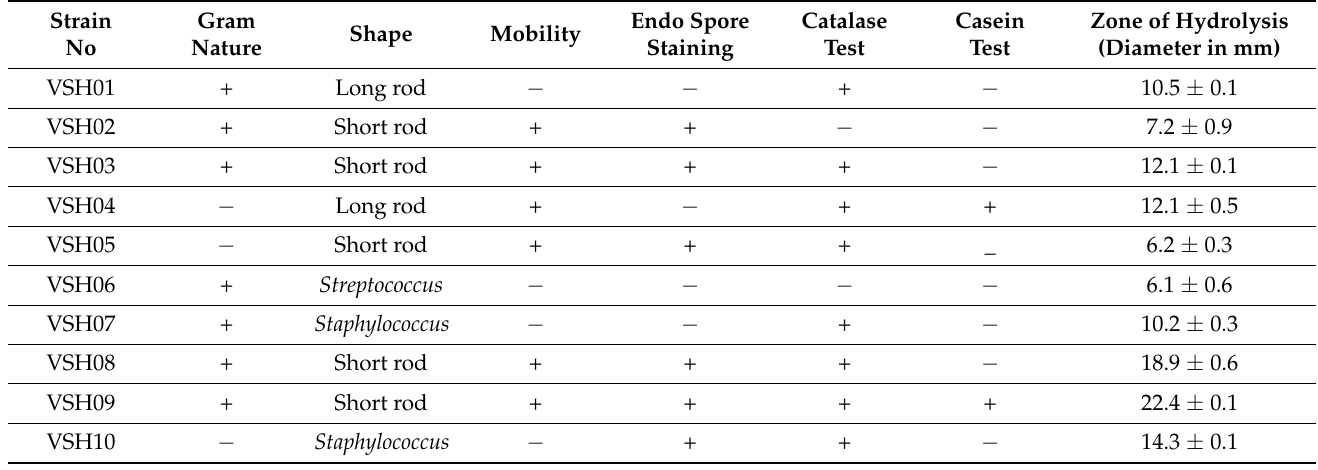
Table 1. Morphological and biochemical characterization of bacterial isolates.